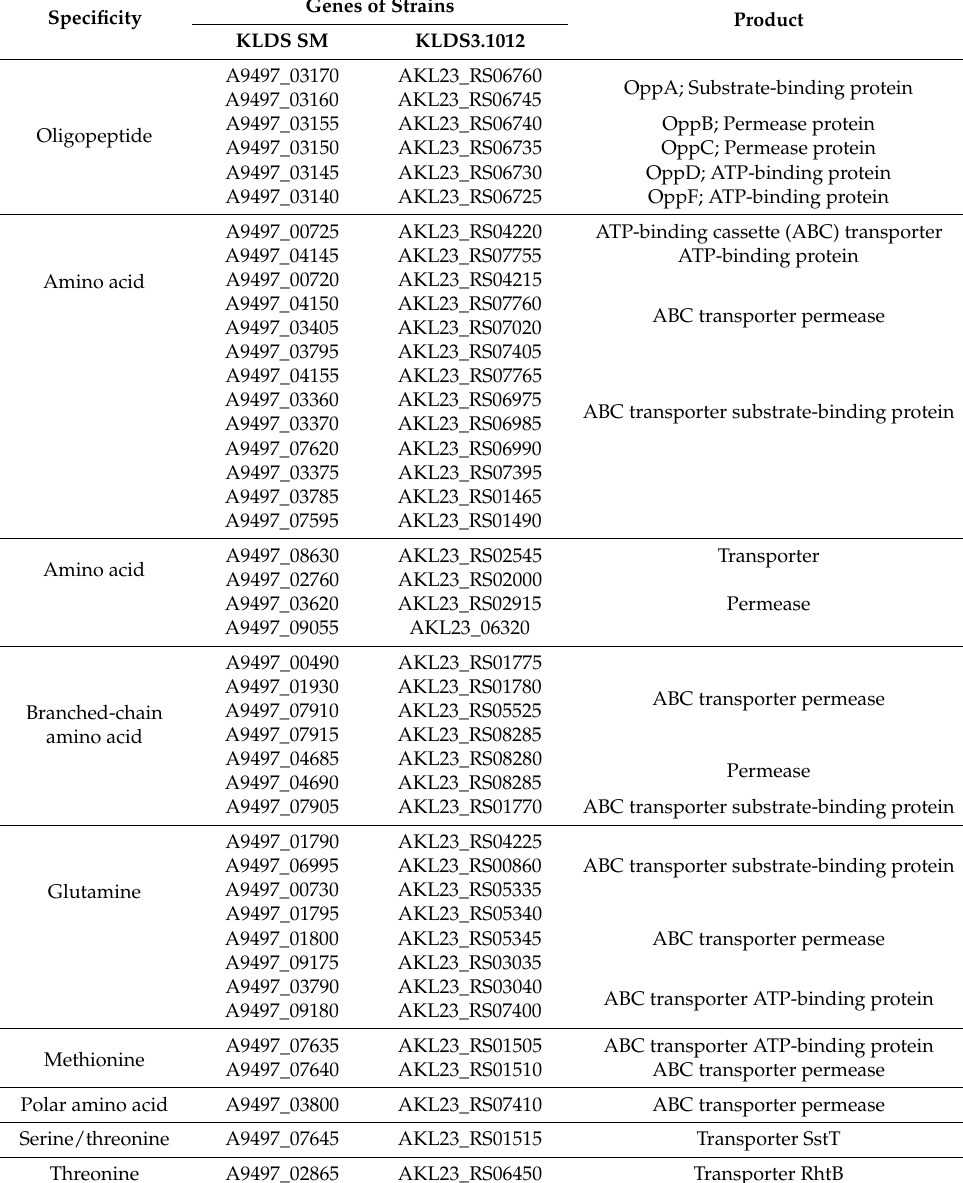
Table 2. Peptide and amino acid transport systems in strains KLDS SM and